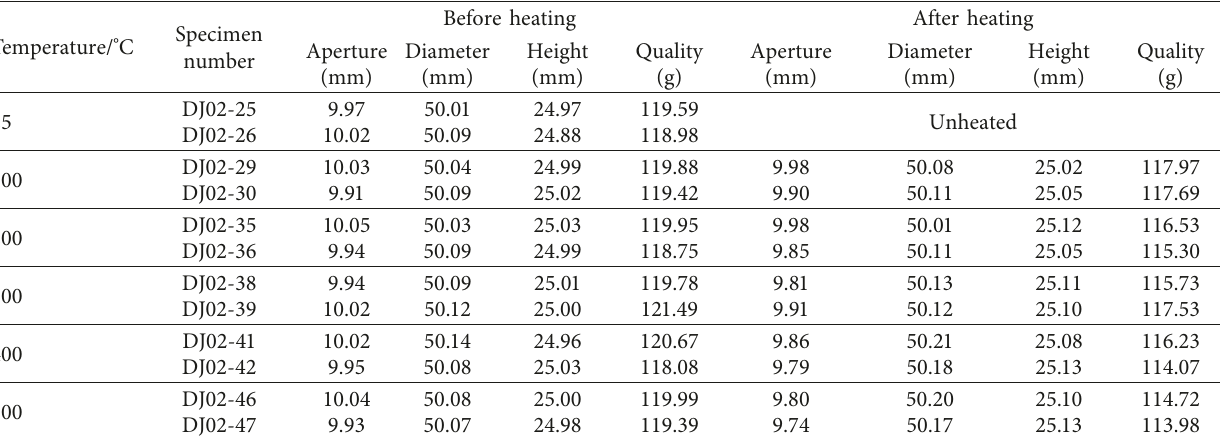
Table 1: Basic physical parameters of annular samples.